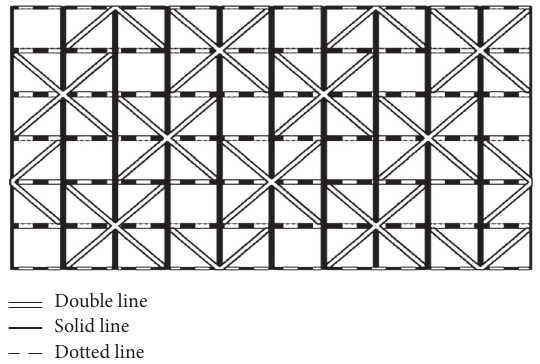
Figure 6: Pleated fabric pattern with transverse folding The results of the analysis of covariance are shown in Figure 8. The adjusted average and standard errors of